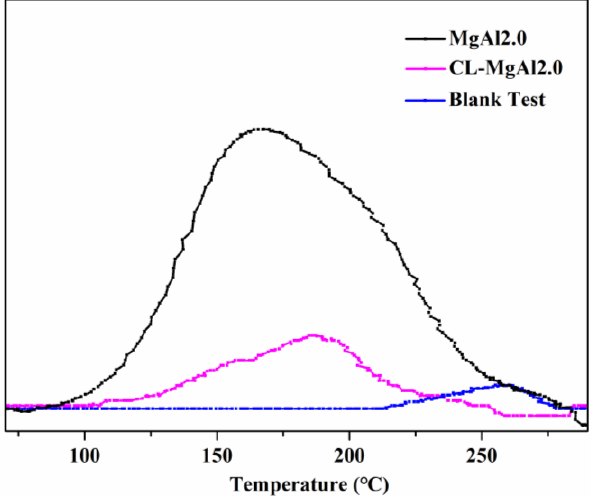
Figure 9. CO 2 -TPD diagrams of MgAl2.0 and its crosslinked counterpart (CL-MgAl2.0). Table 3. Desorption peak temperature and area of MgAl2.0 and its crosslinked counterpart. LDHs Temperature/ ◦ C Area